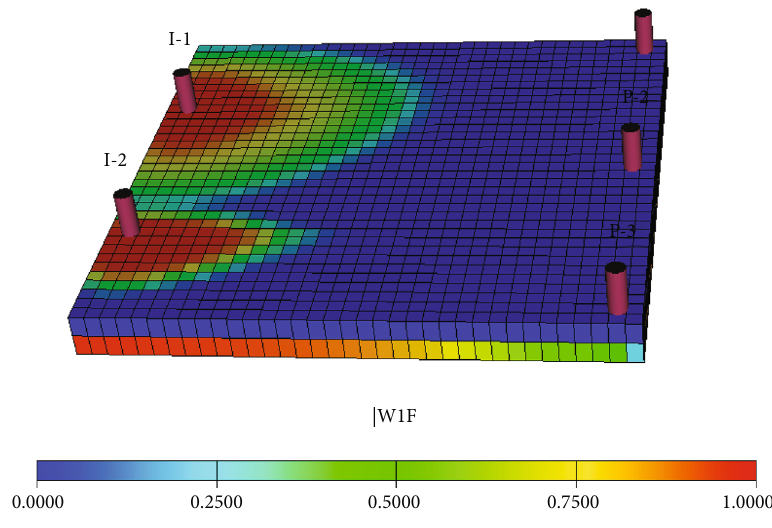
Figure 2: Numerical simulation model. Table 1: Parameters in the